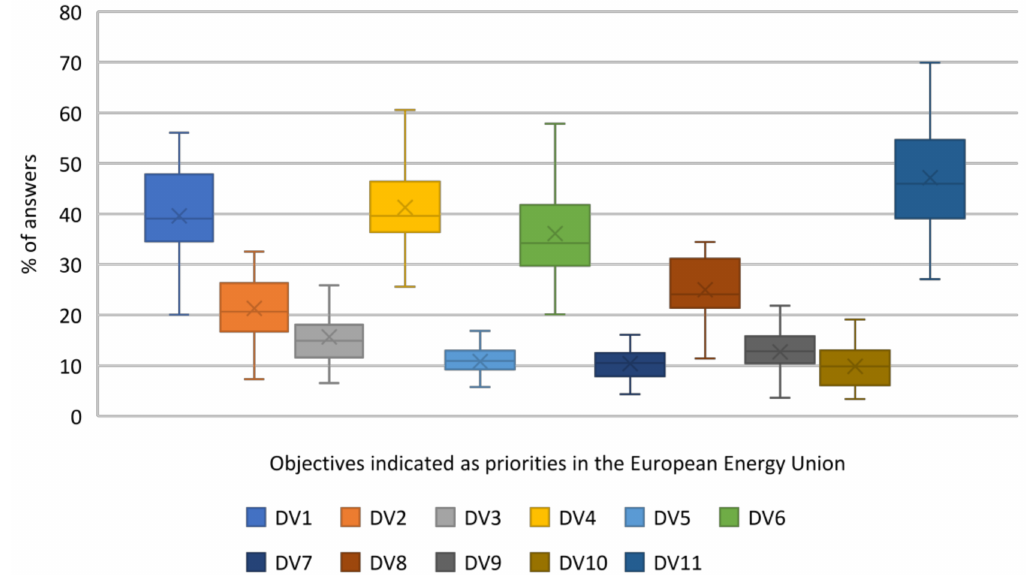
Figure 2. Box plots of objectives indicated by the EU countries as European Energy Union priorities. Note: Whiskers represent the minimum and maximum percentage of answers given by the respondents of EU countries on each priority. The box is drawn from Q1 to Q3 with a horizontal line drawn in the middle to denote the median. The sign X represents the mean value for each